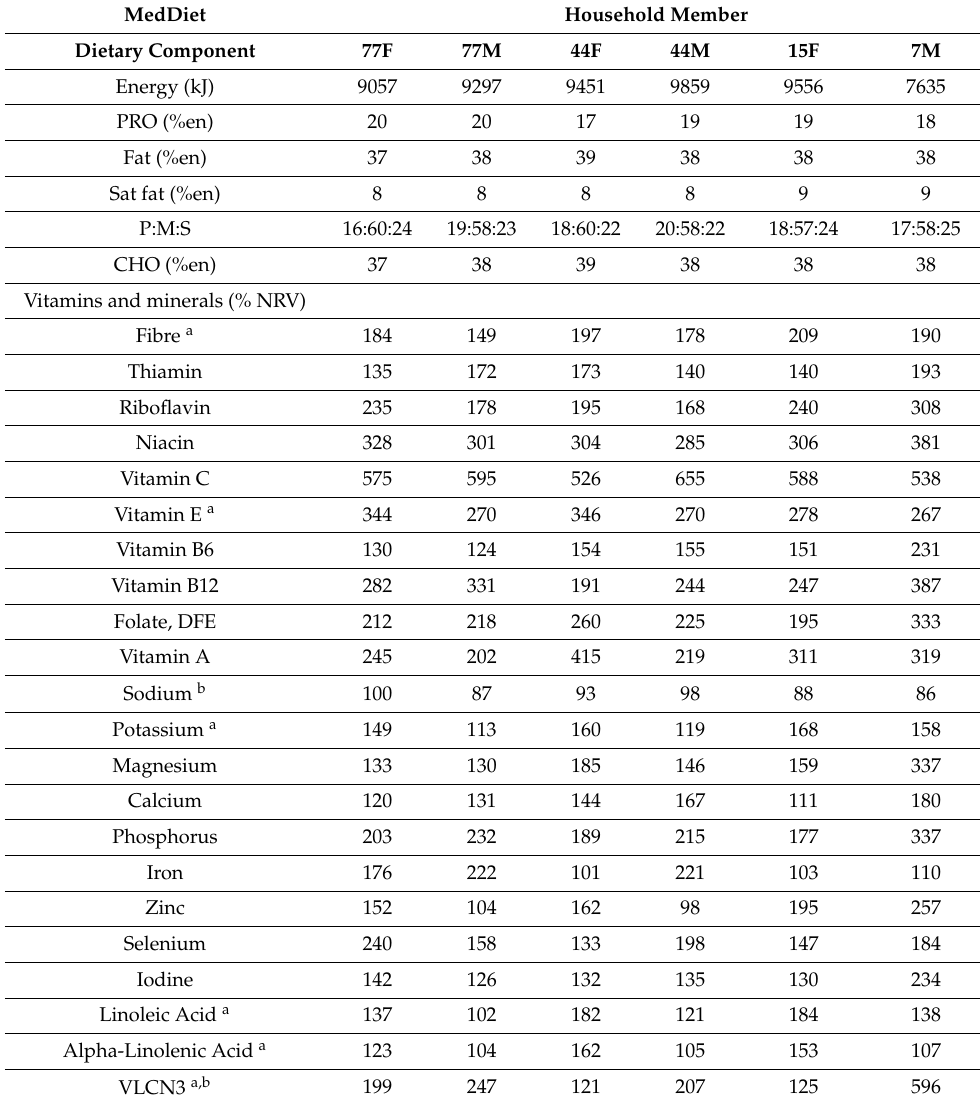
Table 8. Summary of average daily nutrient intake by household member for the Mediterranean food